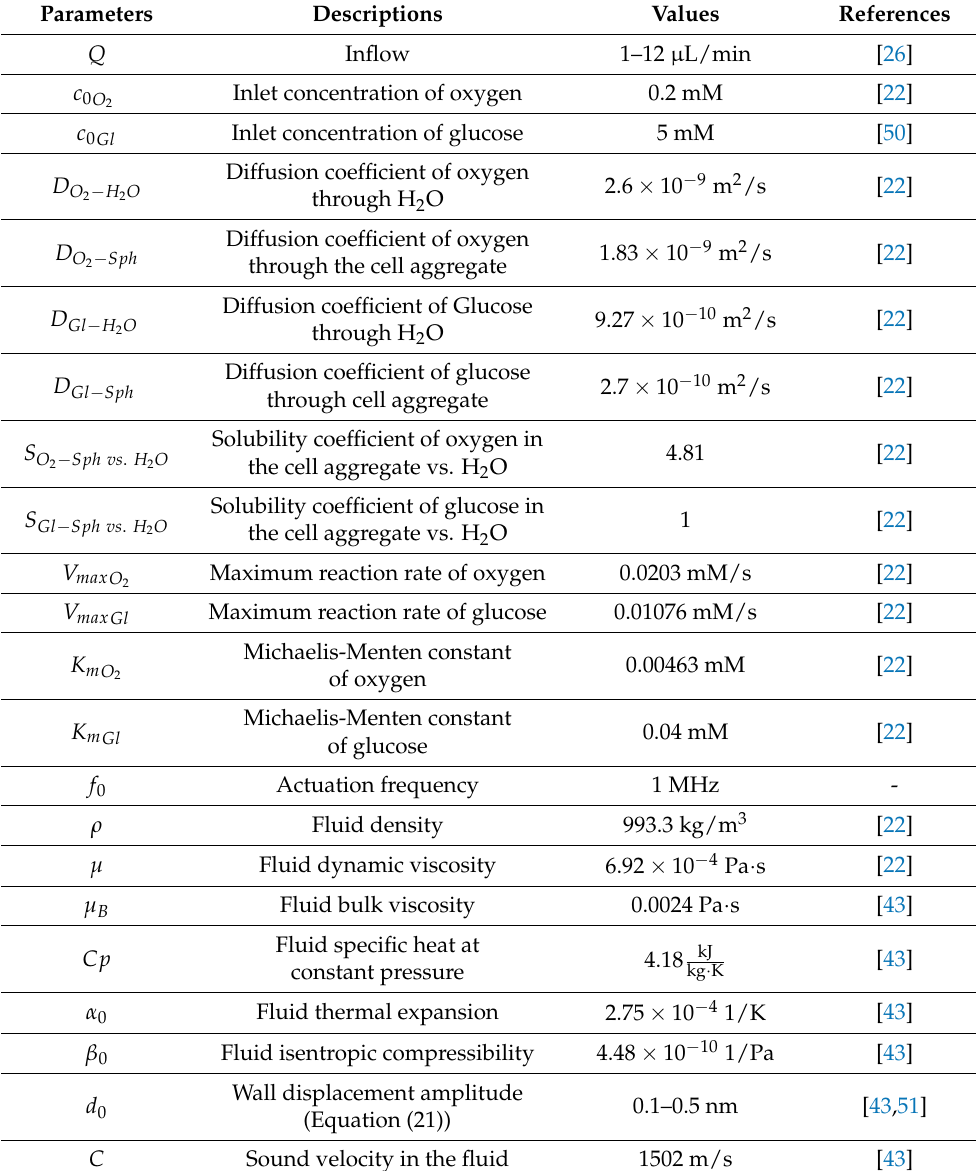
Table 2. Detailed values and descriptions of all the parameters used in the governing equations used in this